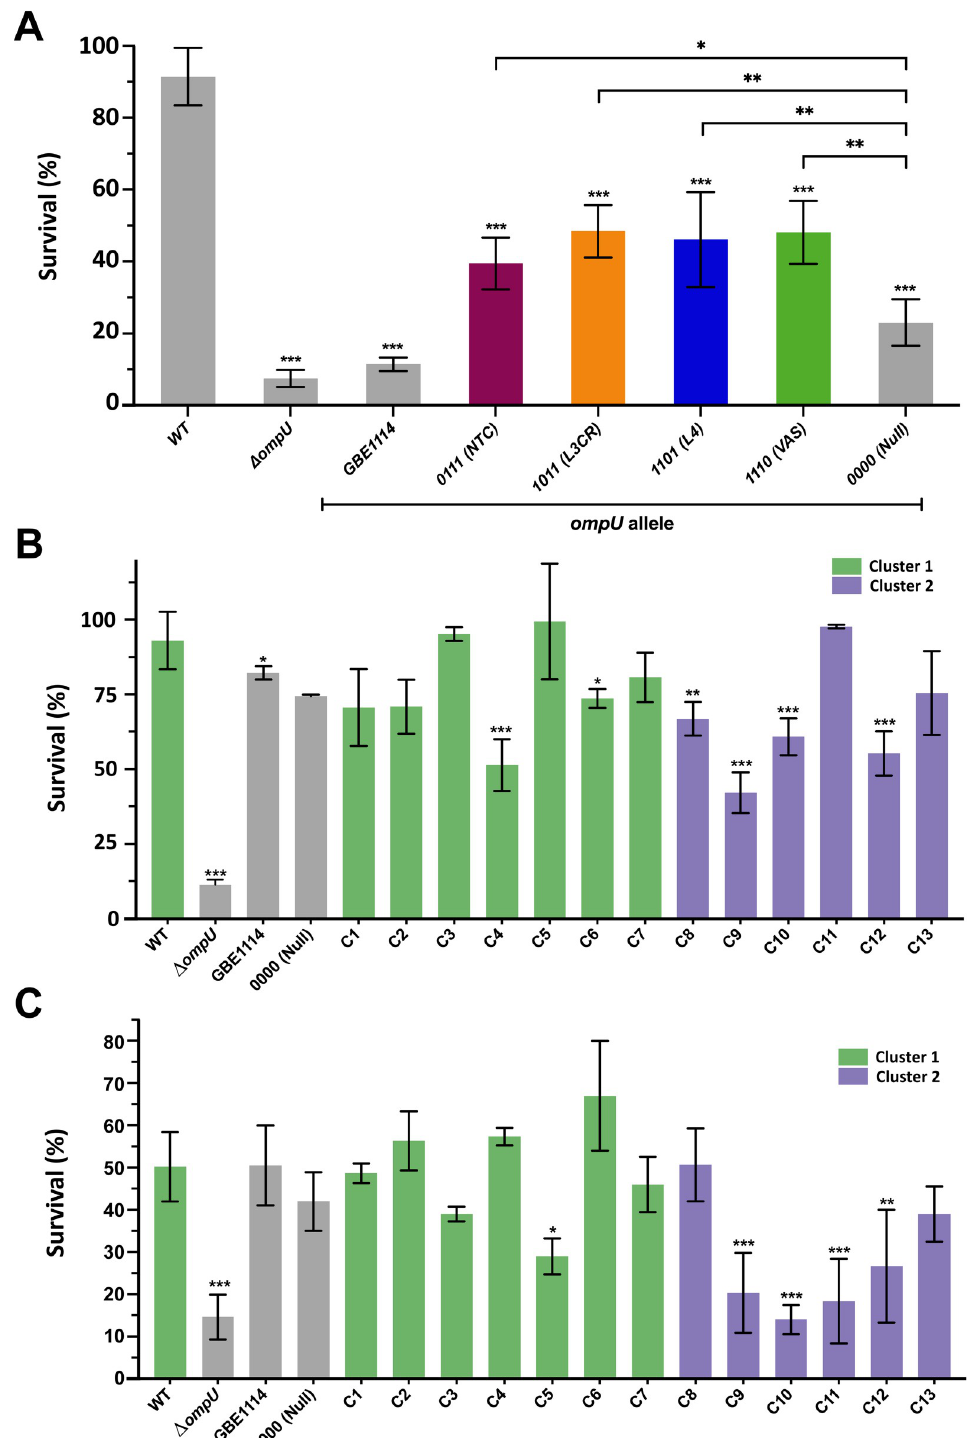
Fig 4. Role of protein domains in OmpU-associated phenotypes. Survival of V . cholerae N16961 ompU mutant strains in the presence of (A) 200ug P2, (B) polymyxin B (450UmL -1 ) and (C) organic acid (0.005X). Error bars represent the standard deviation of the mean from at least three ( N � 3) independent replicates. Statistical comparisons were performed using one-way ANOVA analyses followed by a Dunnett’s multiple comparison test. All constructs were compared to the WT unless otherwise stated. * p < 0.05, ** p < 0.01, *** p < 0.001, **** p < 0.0001.